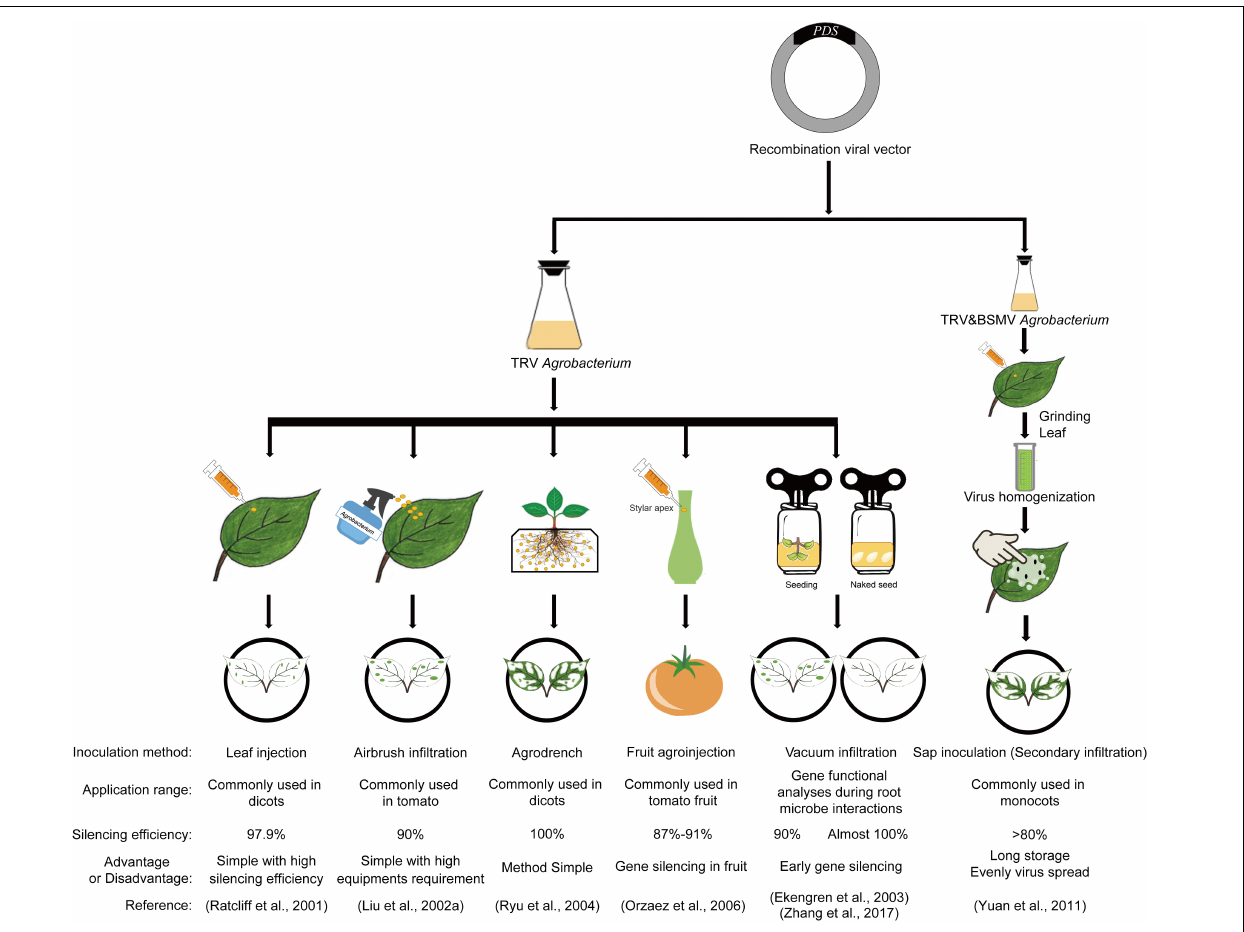
FIGURE 3 | Schematic diagram of different VIGS inoculation methods. The phytoene desaturase , PDS gene was used as an example. Inoculation method, application range, silencing efficiency, advantages and disadvantages, and corresponding references are all included. TRV: Tobacco rattle virus; BSMV: Barley stripe mosaic